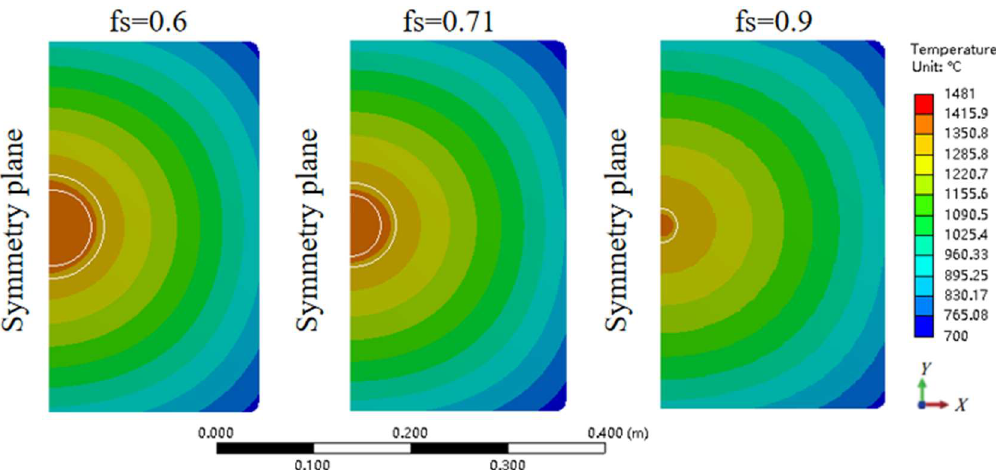
Figure 10. Temperature distribution at different central solidification fractions .